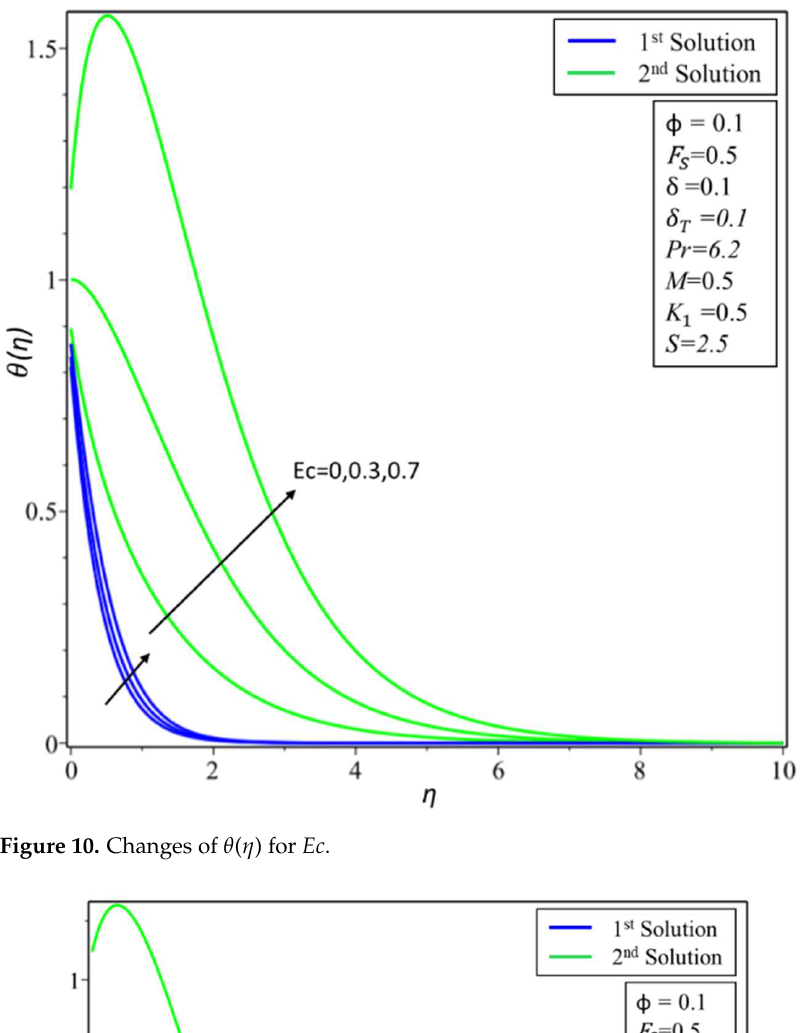
Figure 10. Changes of θ ( η ) for Ec .